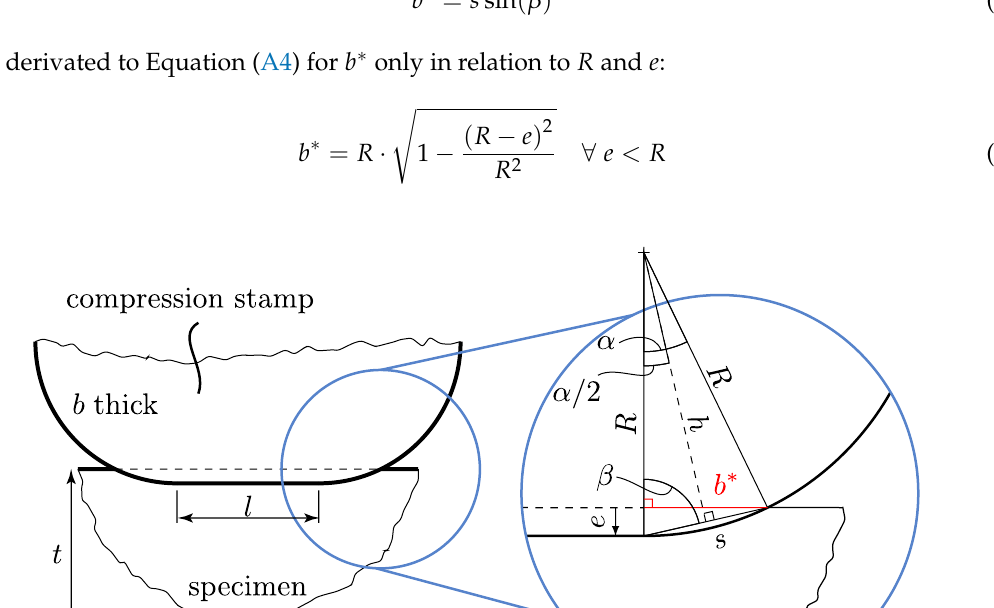
Figure A1. Geometrical dimensions in the vicinity of the stamp radii for determination of the apparent stress state of the ( σ t w / σ c 3